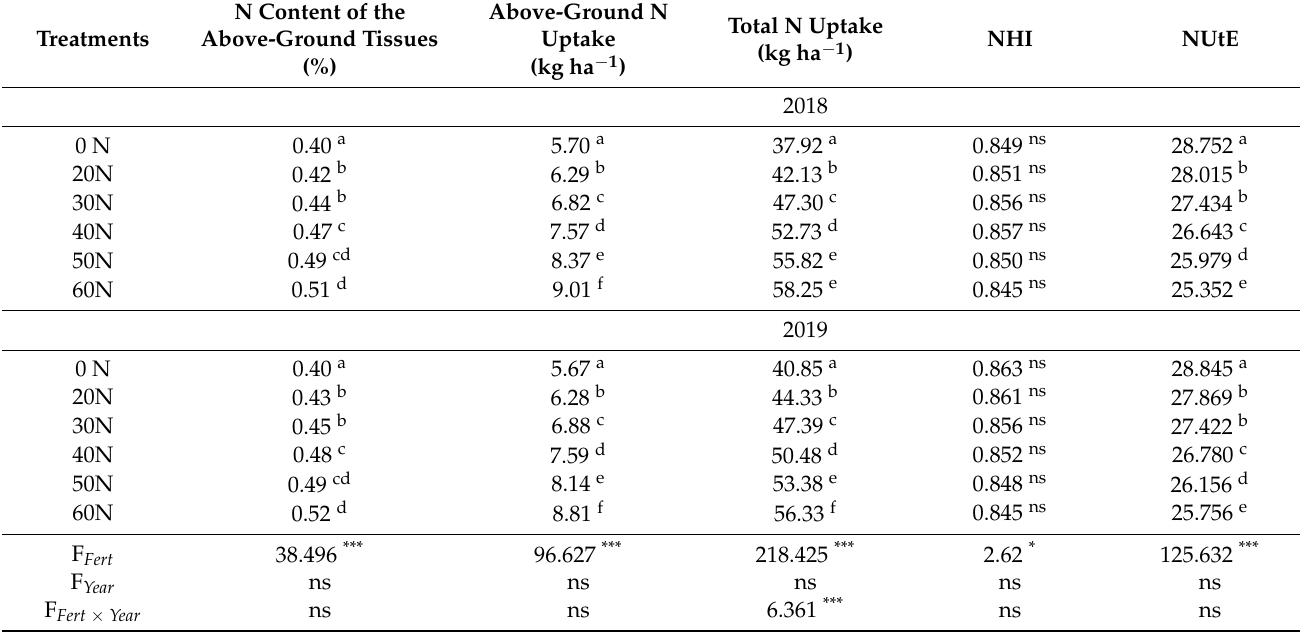
Table 2. The N content of the above-ground plant tissues, the Above-ground and Total N Uptake, and the N indices, as affected by the